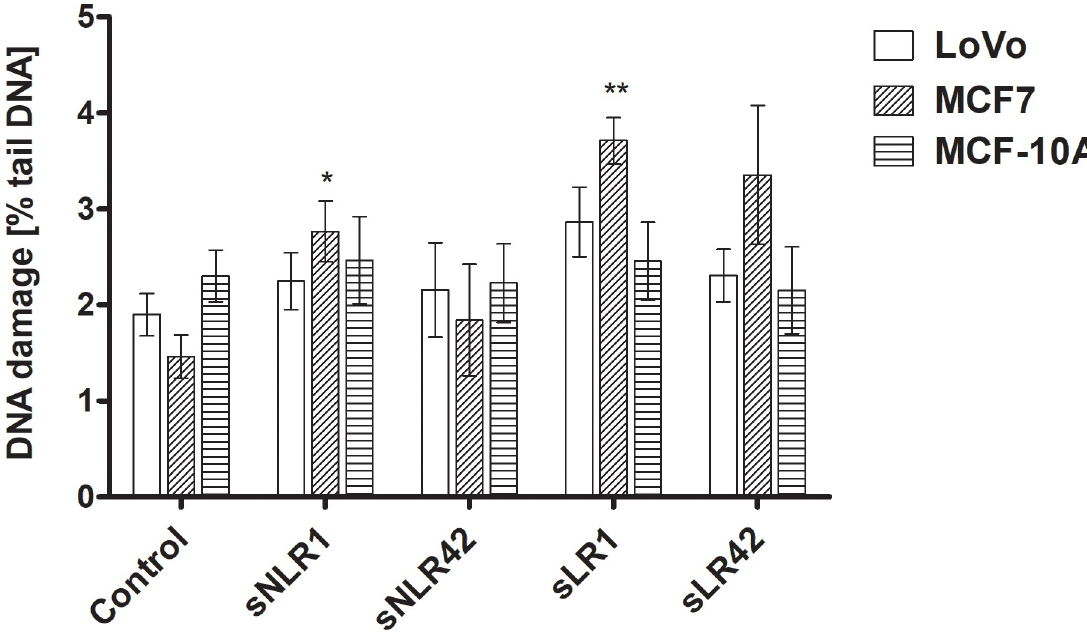
Fig 4. The DNA damage, measured as a percentage of tail DNA in the alkaline comet assay, in LoVo, MCF7, and MCF-10A cells pre- incubated for 1 h at 37˚C with the PRBC supernatants (5%). All experiments included a negative (untreated cells) and positive (cells treated with 10 μ M H 2 O 2 ) control. Error bars denote ± SD, n = 15 (3 independent experiments, each performed with supernatants of PRBCs derived from five donors); � p < 0.05; �� p < 0.01 compared to untreated